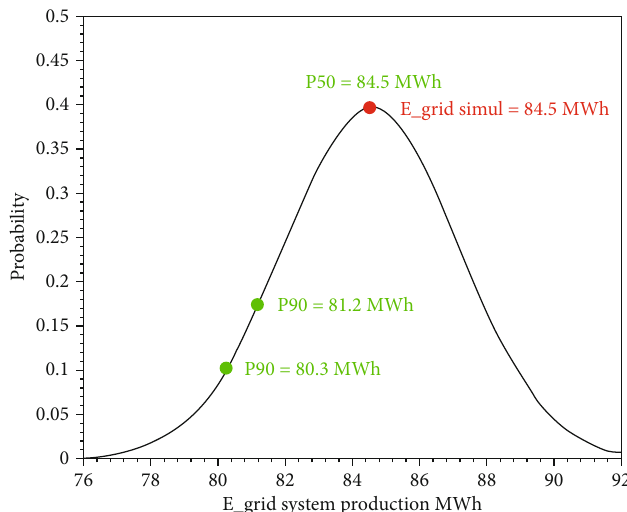
Figure 3: P95/P90/P84.5 probabilities for the energy generation forecasts from the SE cooler (PVsyst).